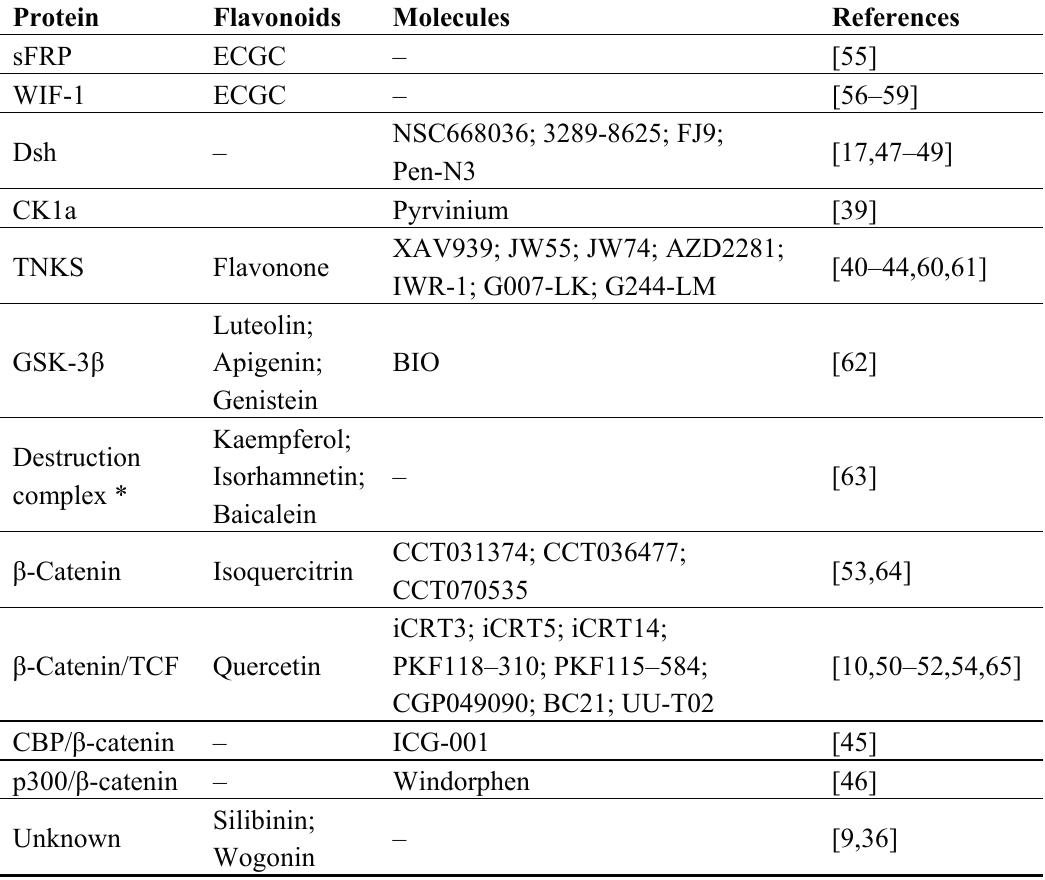
Table 1. List of synthetic and natural small molecules and their target protein on Wnt/ β -catenin signaling pathway. * studies do not point out the specific